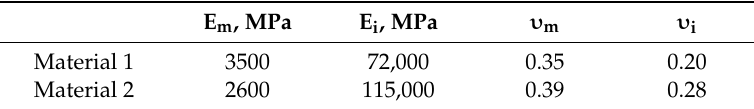
Table 1. Material Properties of the Composite